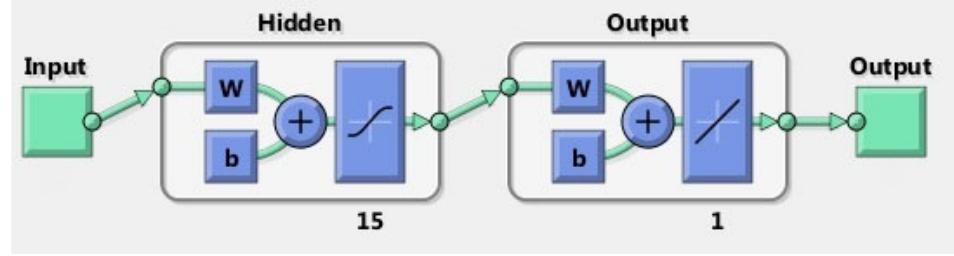
Figure 2. The figure shows the diagram of the ANN model used in this study. Table 1. This table presents the forty-six single features included in this study. The features are presented in the order that these were